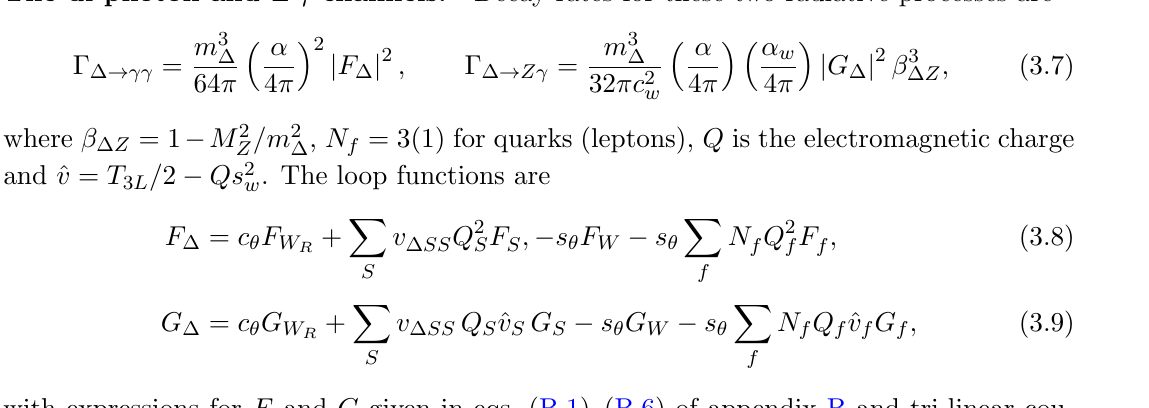
Br 2 , shown on the right of (cid:1) ! NN h ! (cid:1)(cid:1)